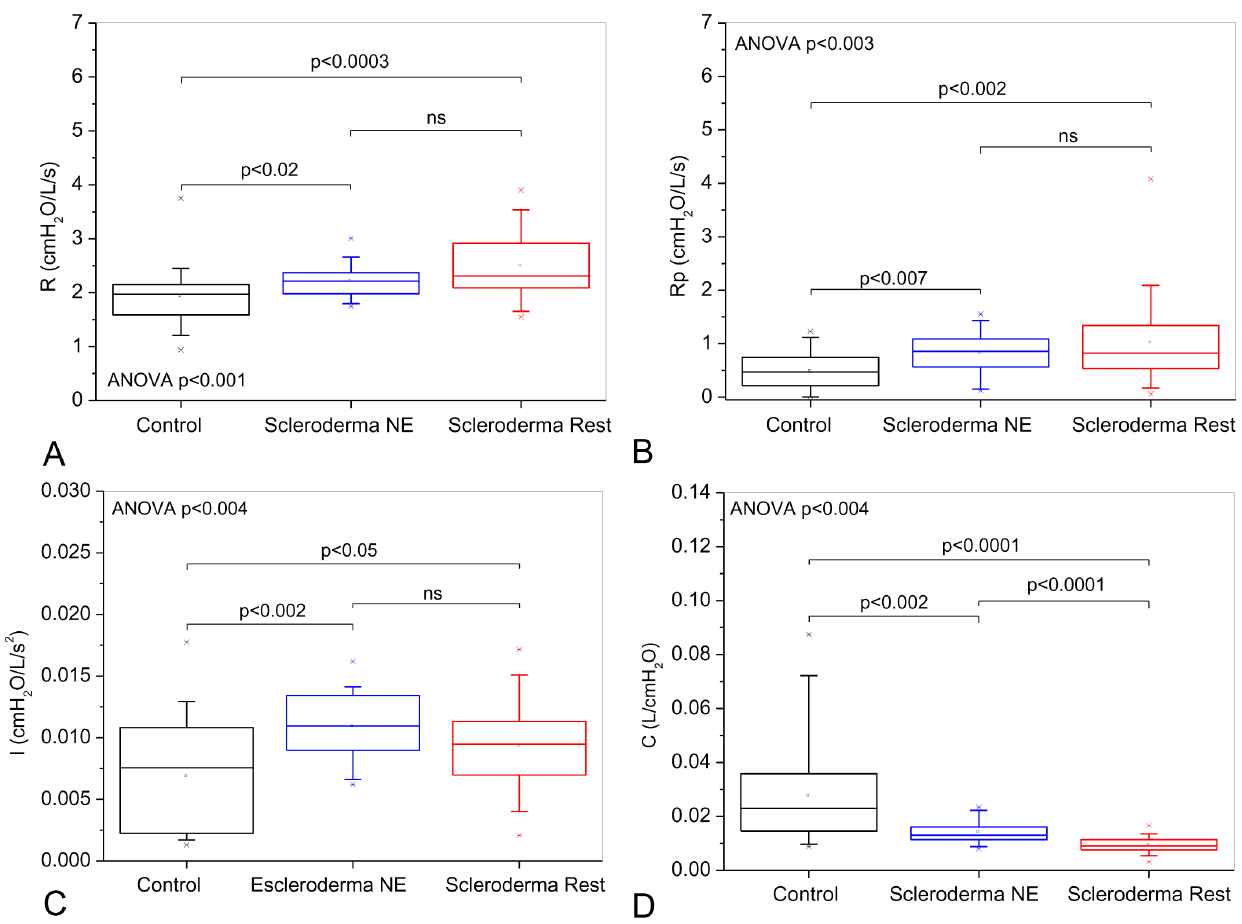
Figure 4. Influence of the pattern classified as restrictive in the spirometric exams on parameter values estimated from the model described in Figure 1. The increasing restriction was accompanied by a correspondent gradual elevation of central (A) and peripheral (B) resistance values. These changes are significant even in patients with normal spirometry. Respiratory inertance (C) increased in SSc. The changes observed in resistance and inertance may be explained by reductions in the radius of the airways. As can be observed in (D), SSc also resulted in reduced values of compliance.